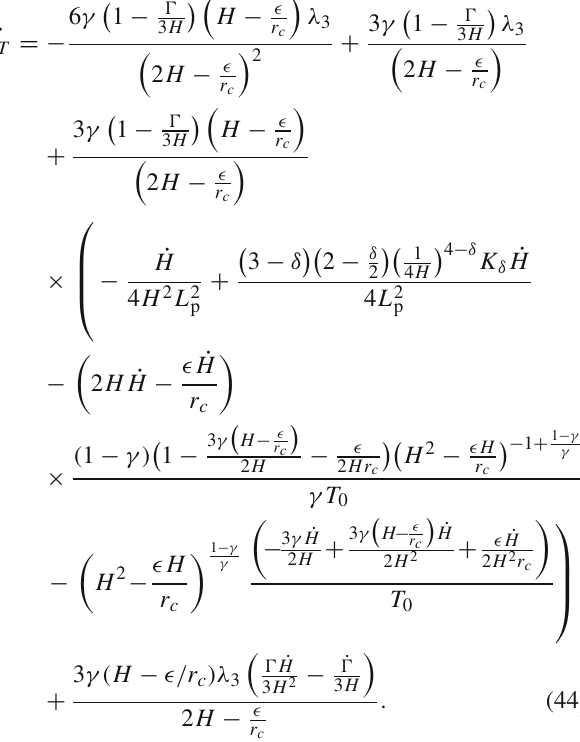
¨ S T and γ for three values of T by setting The plot between the constant values as H = 67, r c = 1